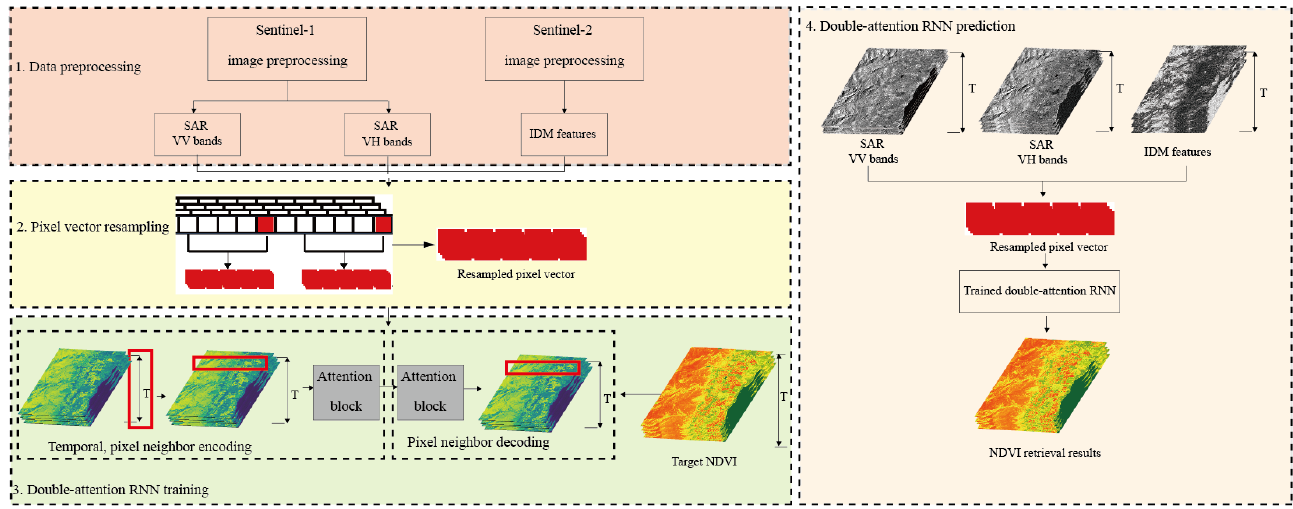
Figure 3. Technical flowchart. After an image preprocessing procedure, resampled feature vectors of SAR and IDM are generated as the input of the double-attention RNN, and these deep features are further extracted in temporal and pixel neighbor domains to recover missing NDVI information.